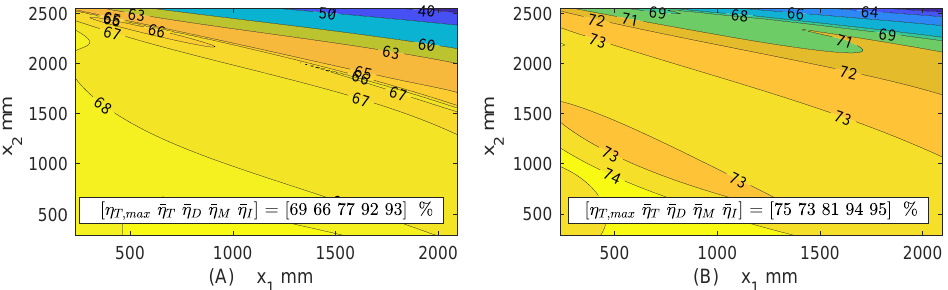
Figure 19. Efficiency for VDN-L in crane application with interconnection scheme 2 ↔ 1 ↔ 3 ↔ 4, 0 ↔ 3. ( A ) total efficiency under payload extension, − ˙ x 1,max = ˙ x 2,max = 50 mm/s; ( B ) total efficiency under payload retraction, ˙ x 1, max = − ˙ x 2, max = 50 mm/s. ¯ η D , ¯ η M , ¯ η I , ¯ η T , η T,max corresponds to the mean displacement unit, motor, inverter, total efficiencies and maximum total